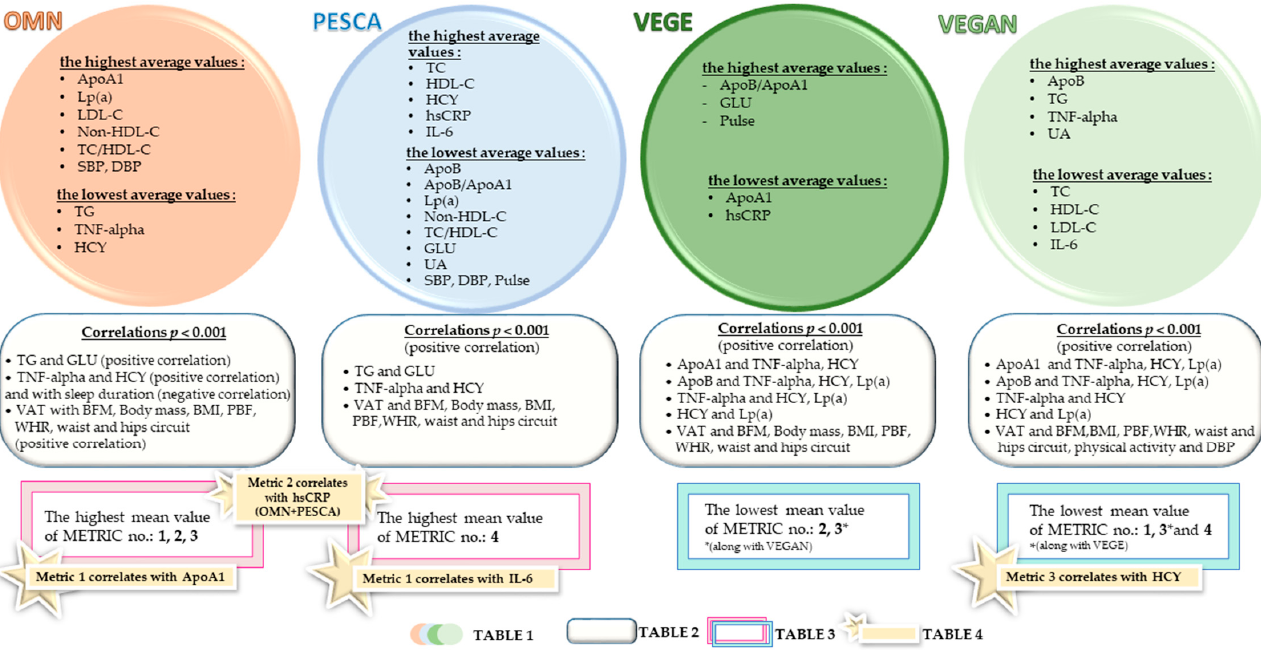
Figure 4. The summary of the study results. Abbreviations: Body Fat Mass (BFM) [kg], Body Mass In- dex (BMI) [kg/m 2 ], Percentage Body Fat (PBF) [%], Skeletal Muscle Mass (SMM) [kg], Waist-Hip Ratio (WHR), Visceral Adipose Tissue(VAT) [cm 2 ], as parameters from I stage of study [38]; parameters